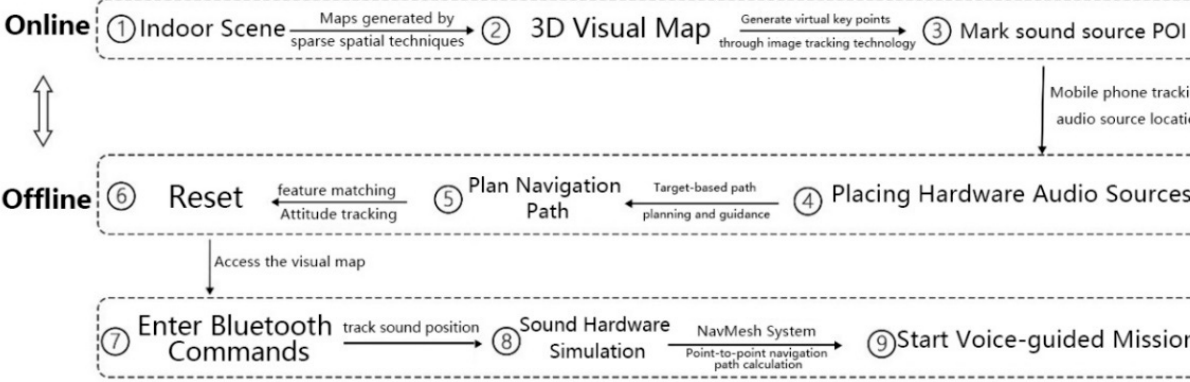
Figure 4. Design concept drawing of orientation aids.